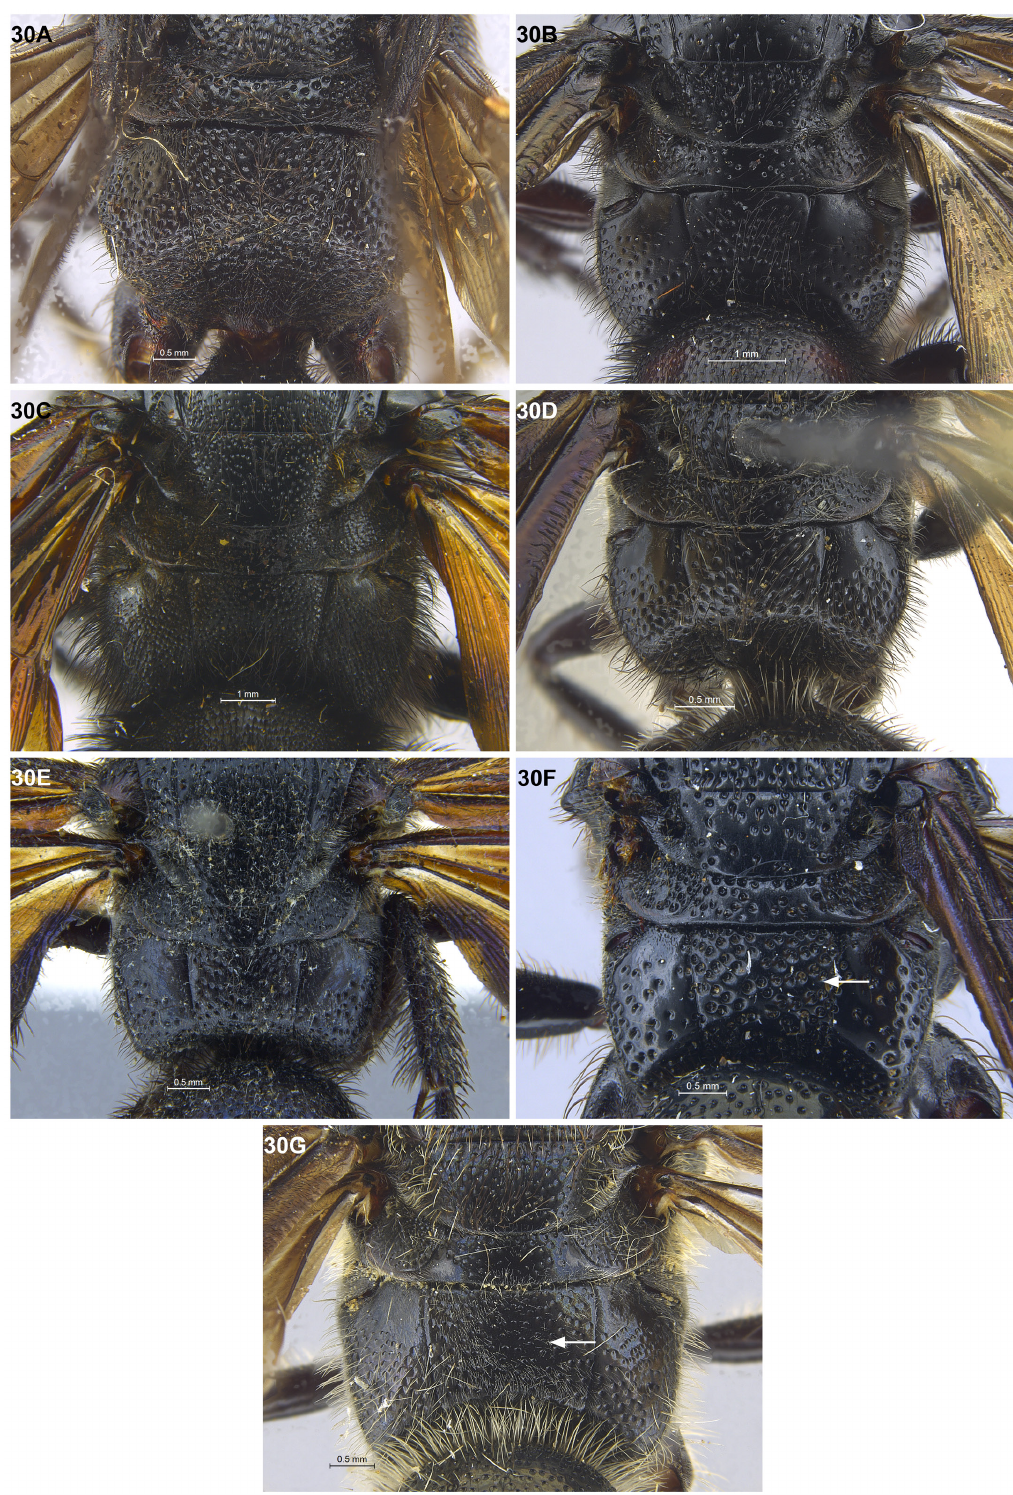
Fig. 30. Males, propodeum. A . Carinoscolia junnanensis (Betrem, 1928).. B . Liacos erythrosoma (Burmeister, 1854). C . Megascolia azurea (Christ, 1791). D . Scolia binotata Fabricius,